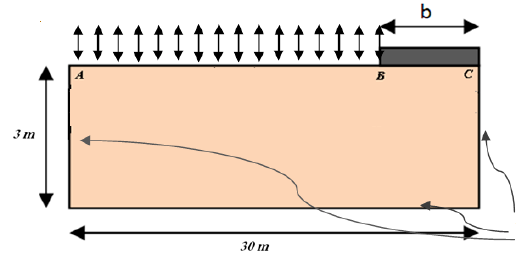
Fig. 8. Numerical model & boundary Figure 8. Numerical model & boundary conditions